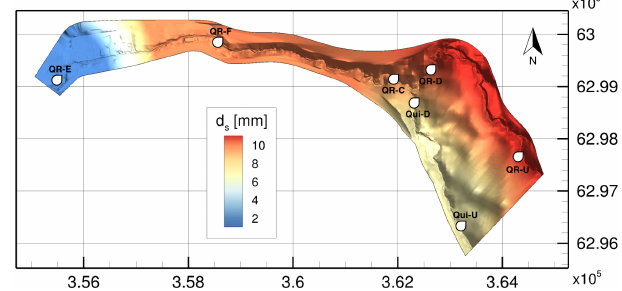
Figure 3. Distribution of the mean sediment size in millimeters. White circles denote the measurement sites where we report the propagation of the flood.